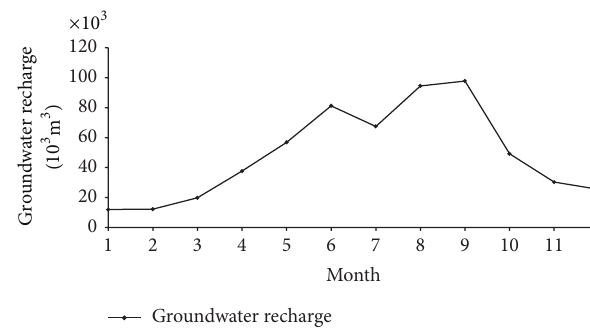
Figure 5: Real-time multireservoirs release.